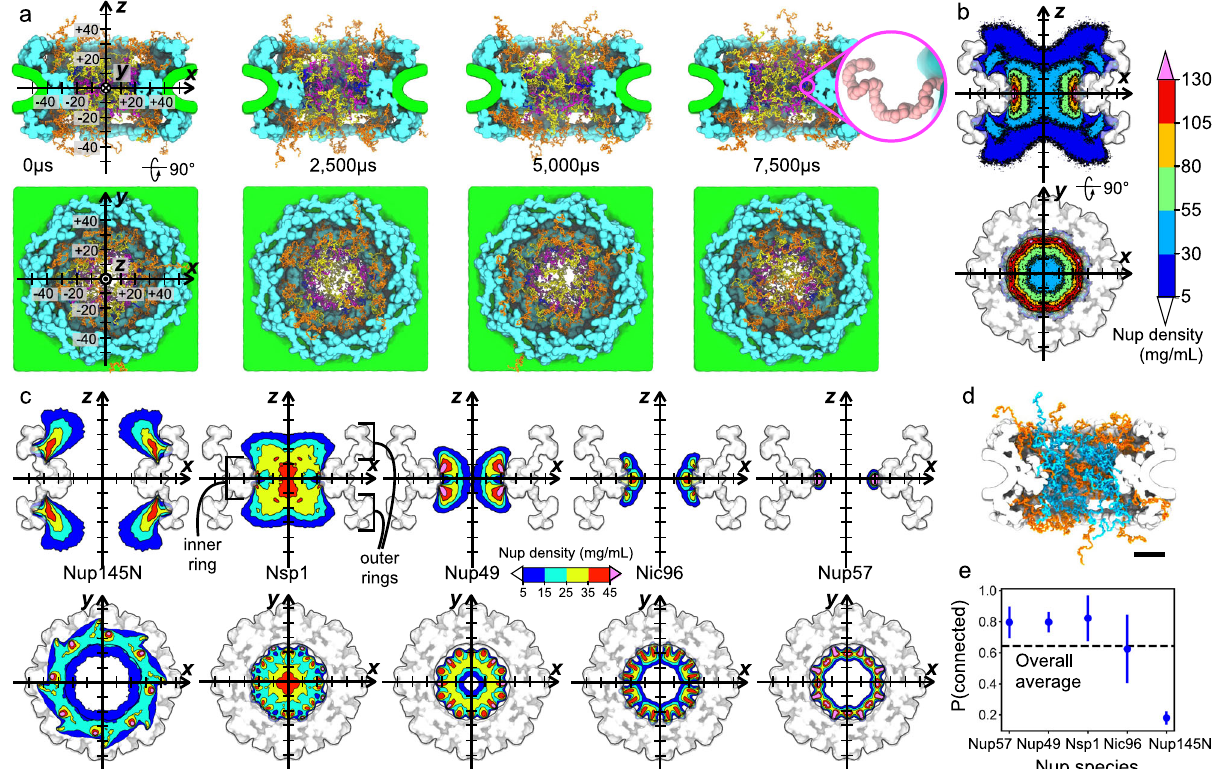
Fig. 1 | Computational model of a composite NPC structure. a Equilibration simulation. The computational model consists of a nuclear envelope (green), structured protein scaffold (cyan), and disordered FG-nups mesh consisting of 32 copies each of Nup145N (orange), Nsp1 (yellow), Nup49 (magenta), Nic96 (dark blue), and Nup57 (pink). Labels for the coordinate system (on the left) are in nm. Inset shows a magni fi ed view of Nup57; each bead represents one amino acid. b CrosssectionsoftheaverageFG-nupamino-aciddensity.The3Ddensitymapwas generated by averaging instantaneous con fi gurations of the computational model every 0.1 μ s over the fi nal 6ms fragments of two independent 7.5ms simulations. The side and top view cross sections were additionally averaged along the y and z